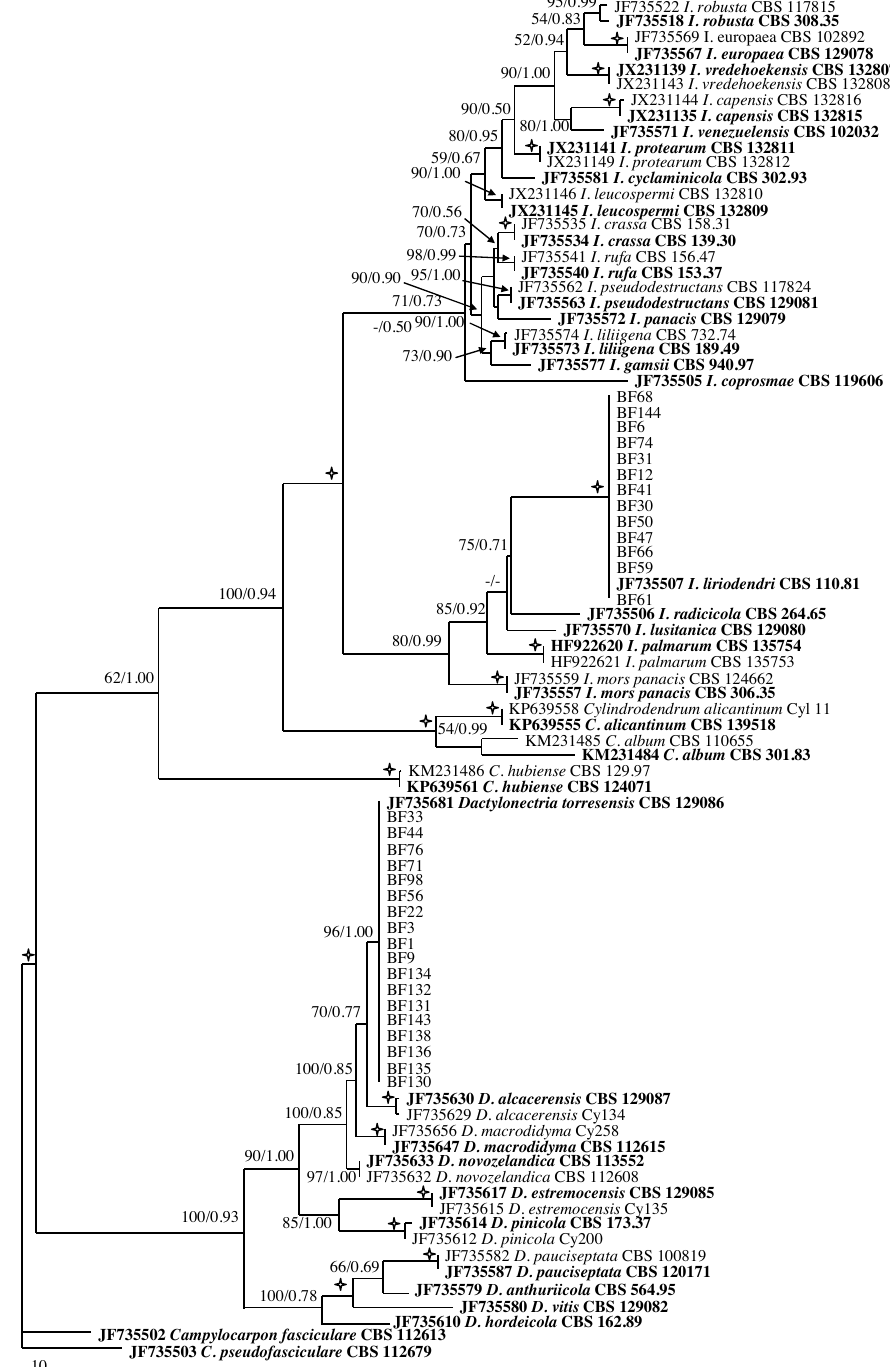
Figure 4. One of the 18 most parsimonious trees obtained from alignment of the His3 sequence data, with bootstrap values from 1,000 replicates from maximum parsimony/Bayesian posterior probability shown at the internodes. Bootstrap values of 100% are indicated with star symbols. Ex-type sequences are highlighted in bold. Campylocarpon fasciculare and C. pseu- dofasciculare were included as